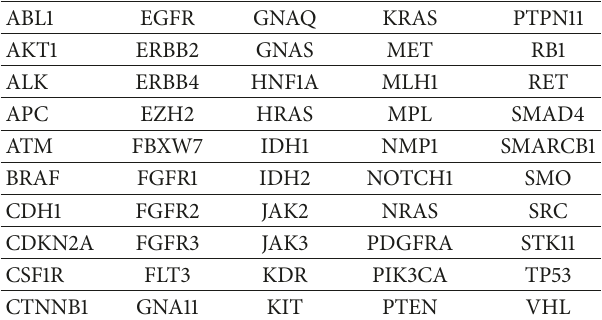
Table 1: Cancer panel used by